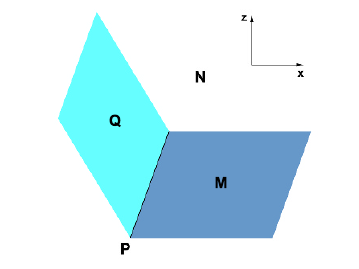
Figure 1 . Geometry of holographic